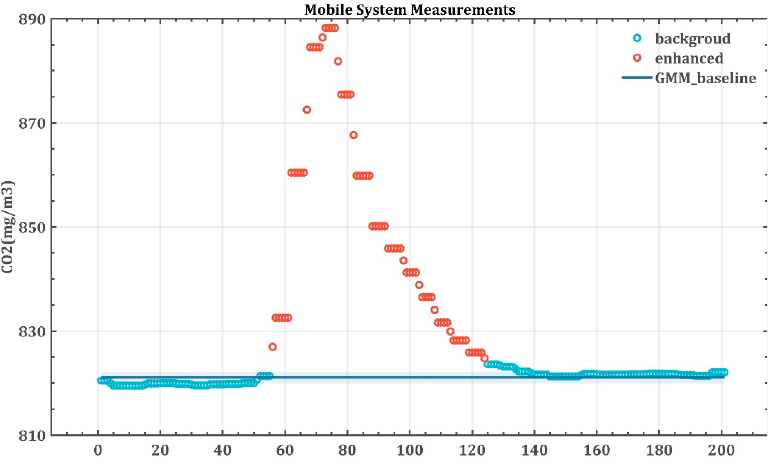
Figure 8. Mobile system measurements.